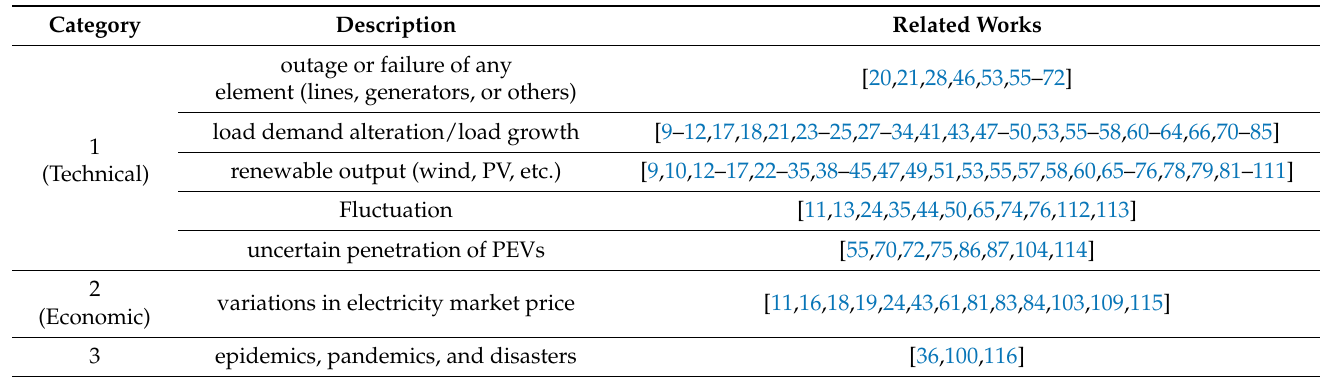
Table 2. Studies Concerning Uncertainty Parameters in Unit Commitment Problem.